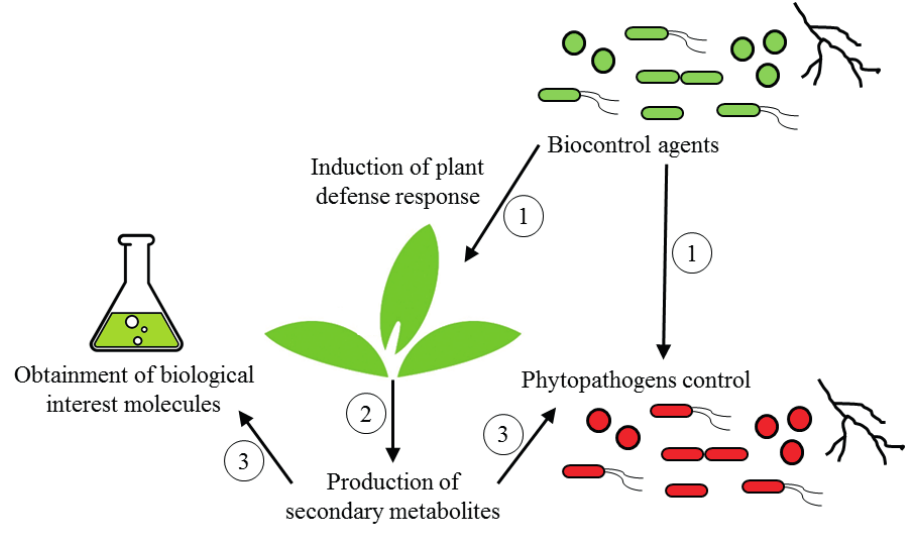
Figure 1 - Phytopathogens controls and obtaining secondary metabolites of interest through defense responses induction in the plant by biocontrol